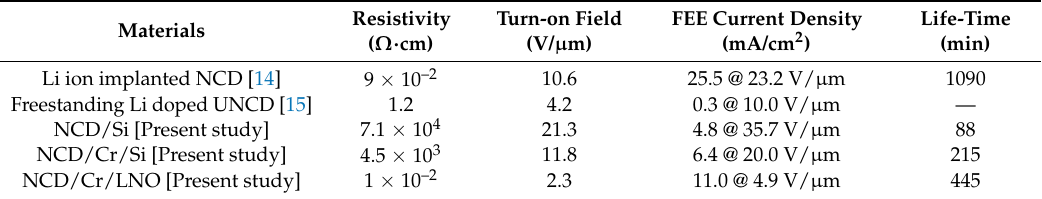
Table 1. Comparison of the field electron emission properties of various Li-incorporated diamond based field